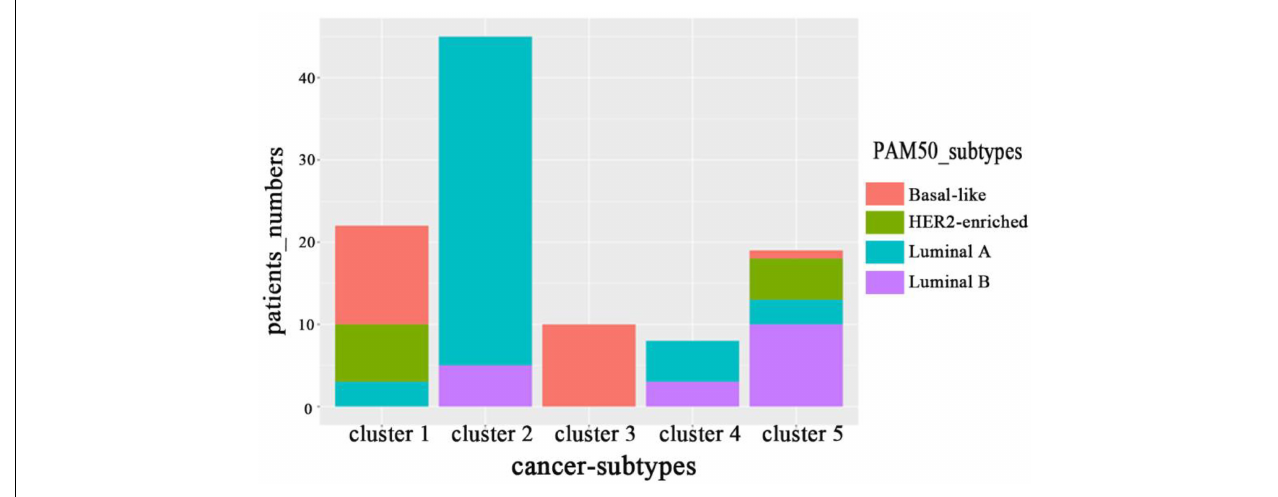
FIGURE 4 | The distribution of subtypes obtained by MRF-MSC on the subtypes: Basal-like, Luminal A, Luminal B and